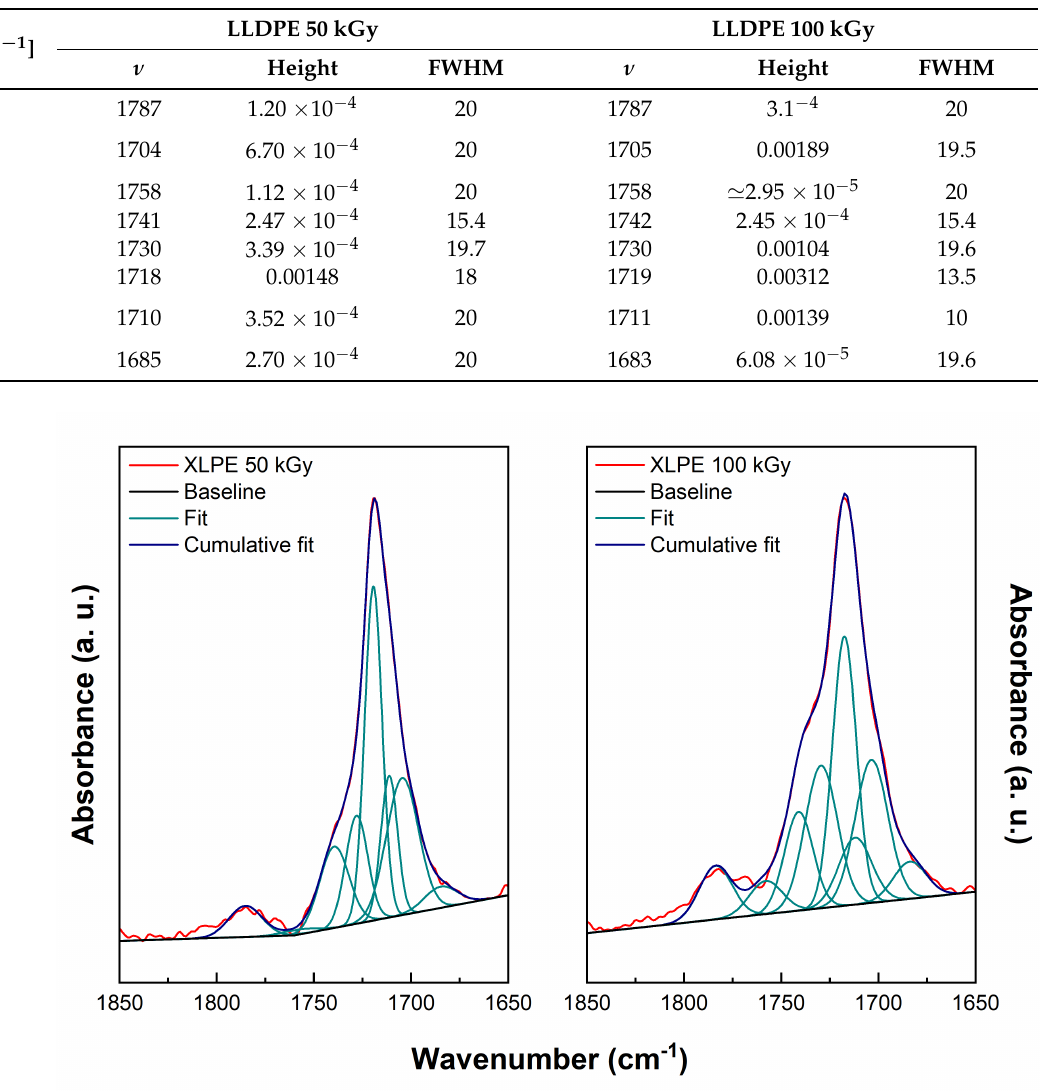
Table 3. Numerical results of the deconvolution for LLDPE irradiated at 50 kGy (left) and 100 kGy (right). Constraints on peak positions ν are in Table 2. FWHM of the fitting Gaussians are constrained between 10 and 20 cm − 1 .